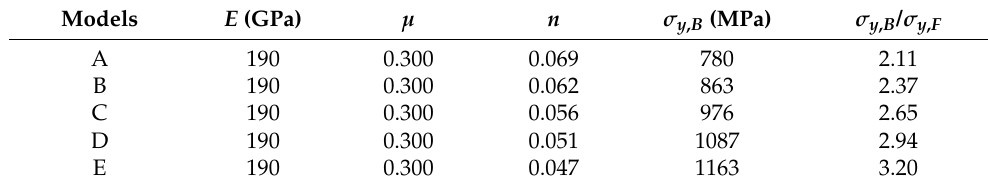
Table 1. Parameters of mechanical properties of bainite and yield strength ratio of bainite to ferrite.